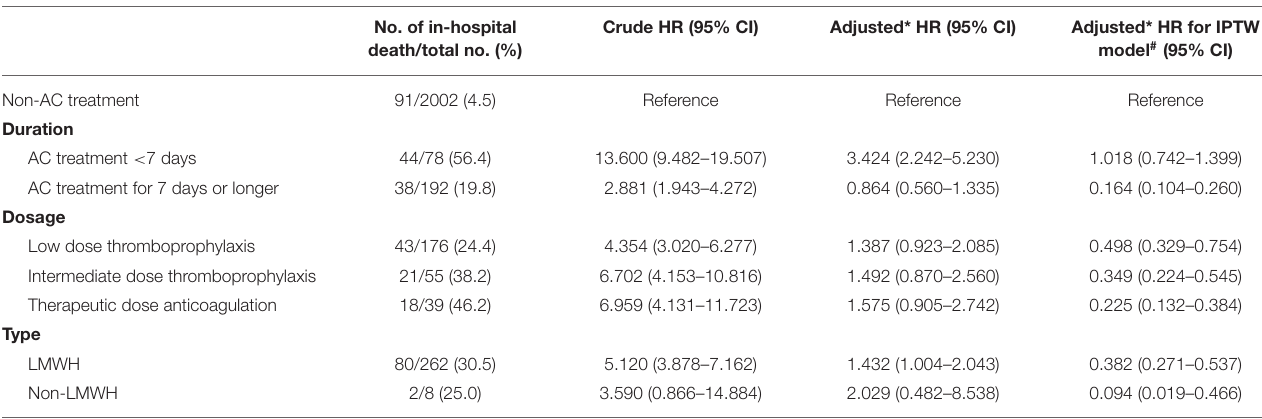
TABLE 3 | Hazard ratio for in-hospital mortality in the full cohort by AC treatment duration, dosage and type in sensitivity